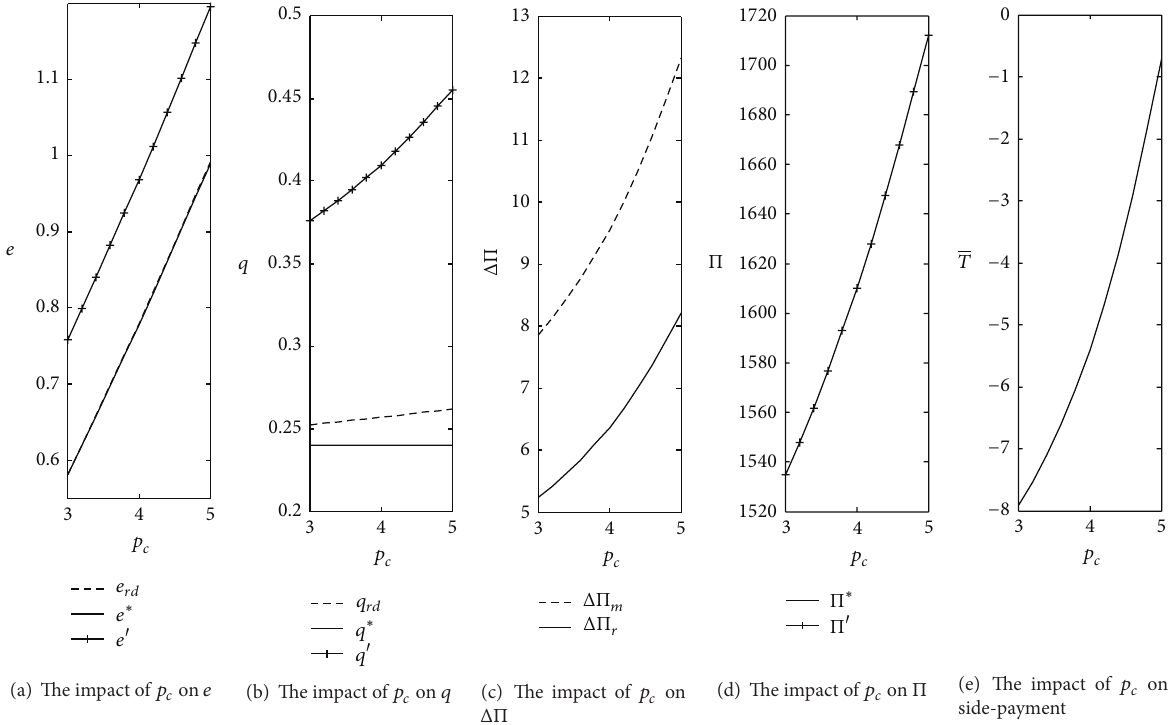
Figure 5: The impact of 𝑝 𝑐 on decision variables and